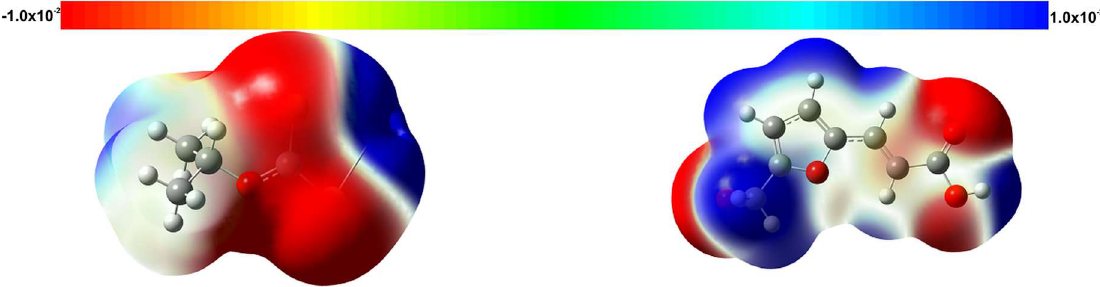
Figure 2. The MEPs of Na-iPrX (left) and HMFA (right) with energy bar in